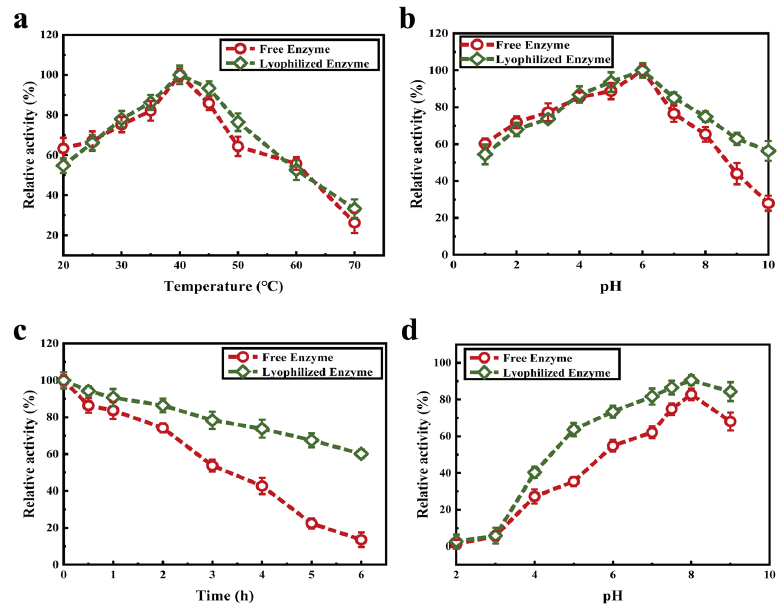
Figure 6. Enzymatic properties of lyophilized enzyme and free enzyme: effects of temperature ( a ) and pH ( b ); their thermal stability ( c ), and pH stability ( d ).